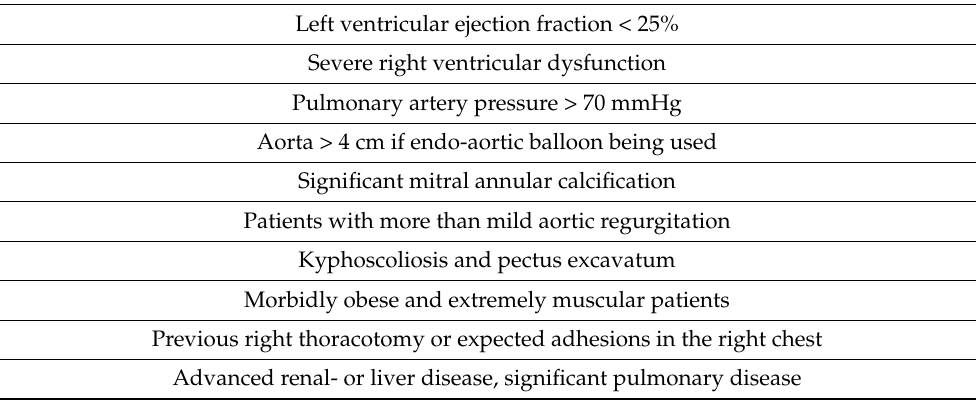
Table 1. Relative contraindications and concerns for MIMVS reported by the International Society for Minimally Invasive Cardiothoracic Surgery (ISMICS). Significant Aortic, Iliac, or Femoral Disease That Prevents Safe Retrograde Arterial